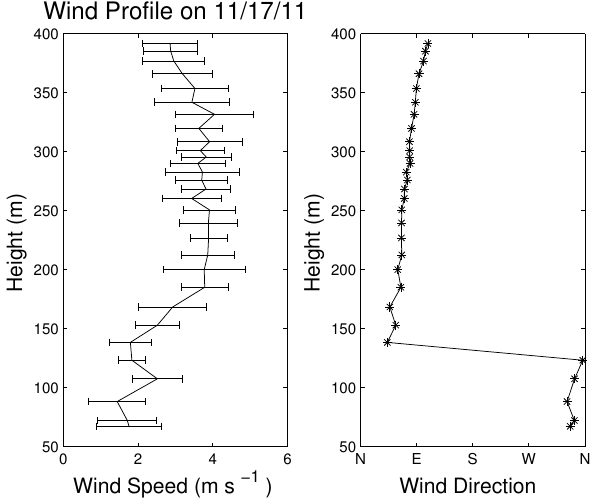
Fig. 4. Derived wind profile by using the BCF on the flight shown Fig. 4: Derived wind profile by using the BCF on the flight shown in Fig. 2. in Fig.